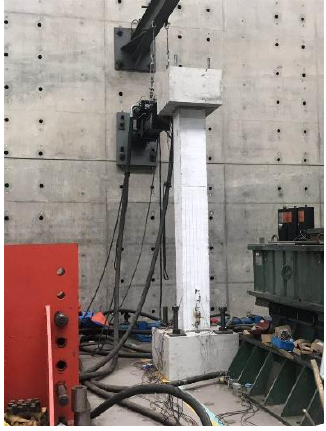
Figure 7. Overview of the test setup.